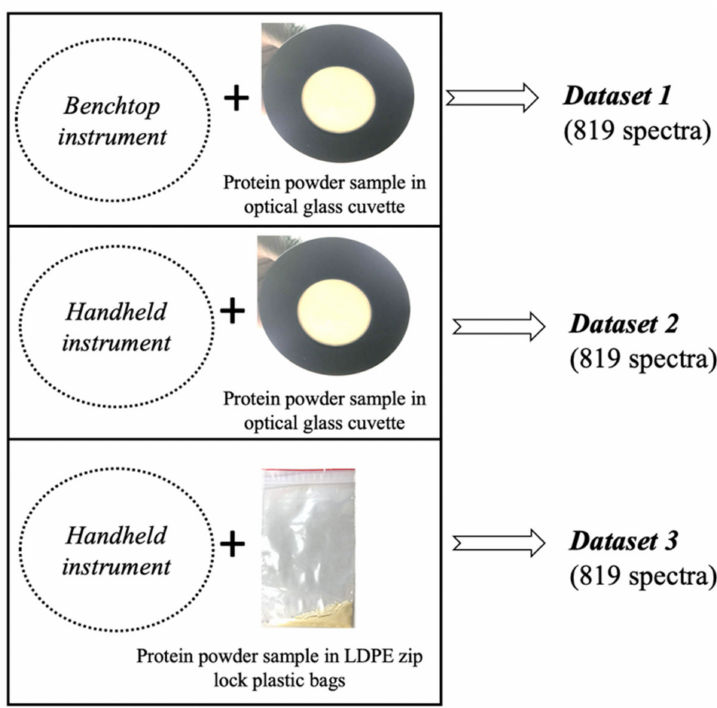
Figure 6. Methods for spectral acquisition of adulterated whey protein powder using the bench top and handheld instrument through a glass window and plastic